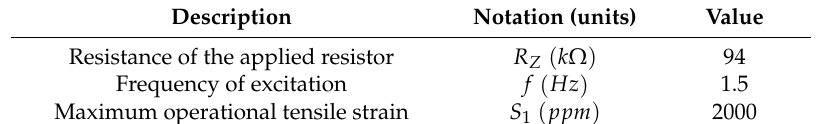
Table 2. The operating parameters of the tested Macro Fibre Composites (MFC) transducer.